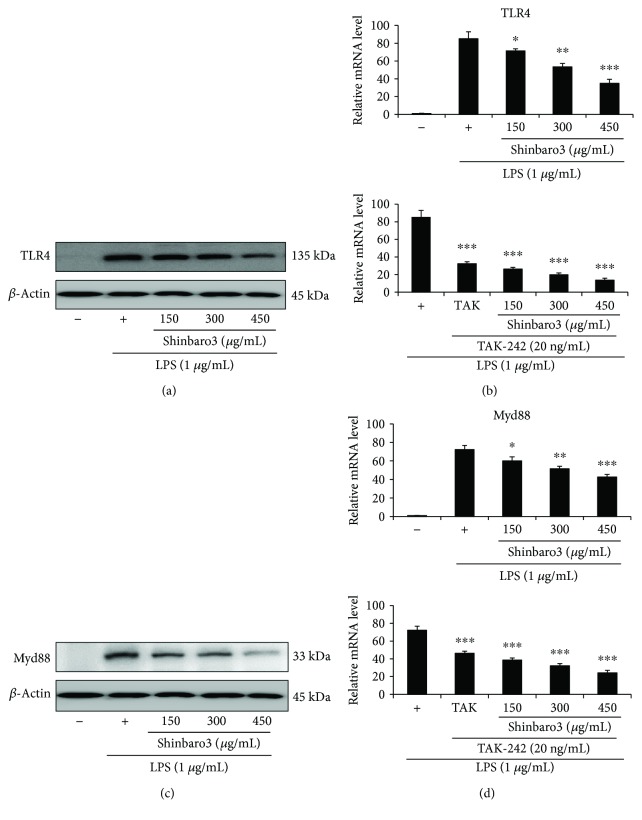
Effects of Shinbaro3 on the TLR4/Myd88 signalling pathway in LPS-stimulated RAW 264.7 cells. RAW 264.7 cells were treated with LPS (1 μg/mL) and Shinbaro3 (150, 300, and 450 μg/mL) for 6 h. (a, b) TLR4 and (c, d) Myd88 protein and mRNA expression levels were analysed via Western blotting and real-time RT-PCR, respectively. The results were normalized using β-actin as an internal control. The data are presented as the mean ± SD (n = 3). ∗p < 0.05, ∗∗p < 0.01, and ∗∗∗p < 0.001 versus LPS treatment alone.